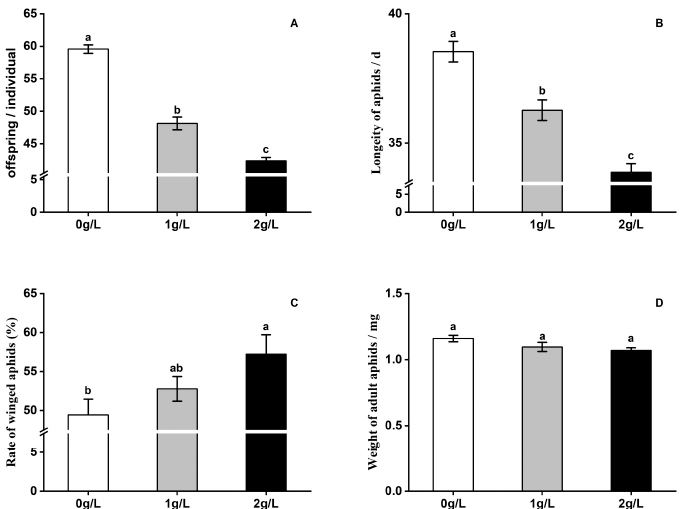
Figure 1. Effect of silicon addition to wheat plants (AK58) on S. avenae development, survival, and reproduction. ( A ): fecundity, ( B ): longevity of aphids, ( C ): rate of winged aphids, ( D ): weight of adult aphids. Different letters over the bars indicate a significant difference ( p < 0.01).